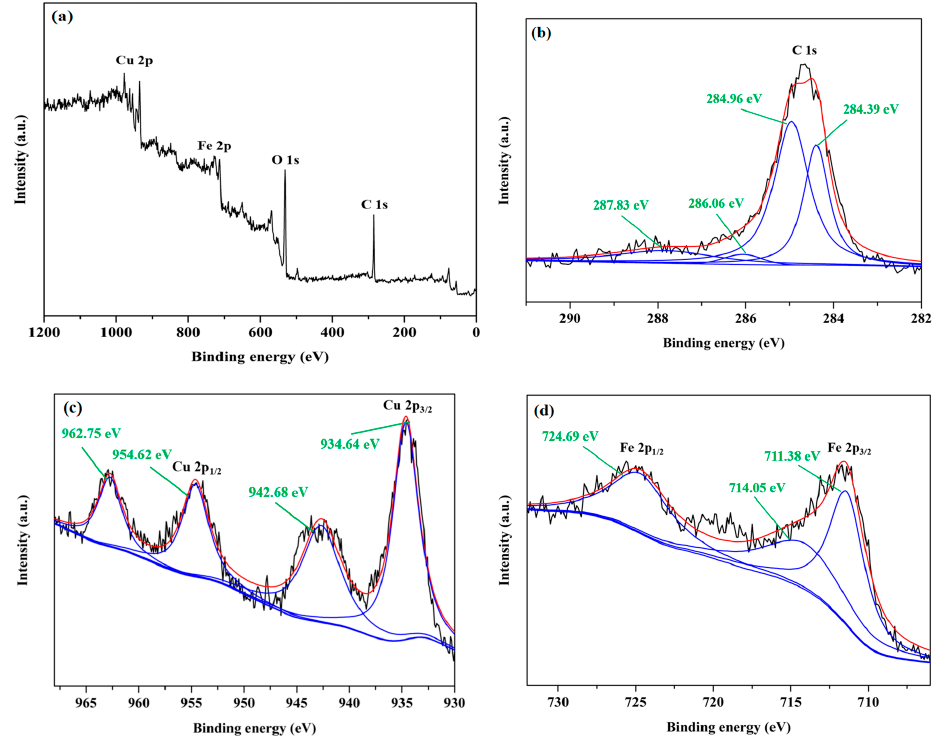
Figure 3. ( a ) Full-range X-ray photoelectron spectra (XPS) spectra of ND/LDH; ( b ) XPS peaks for C 1s; ( c ) XPS peaks for Cu 2p; ( d ) XPS peaks for Fe 2p.